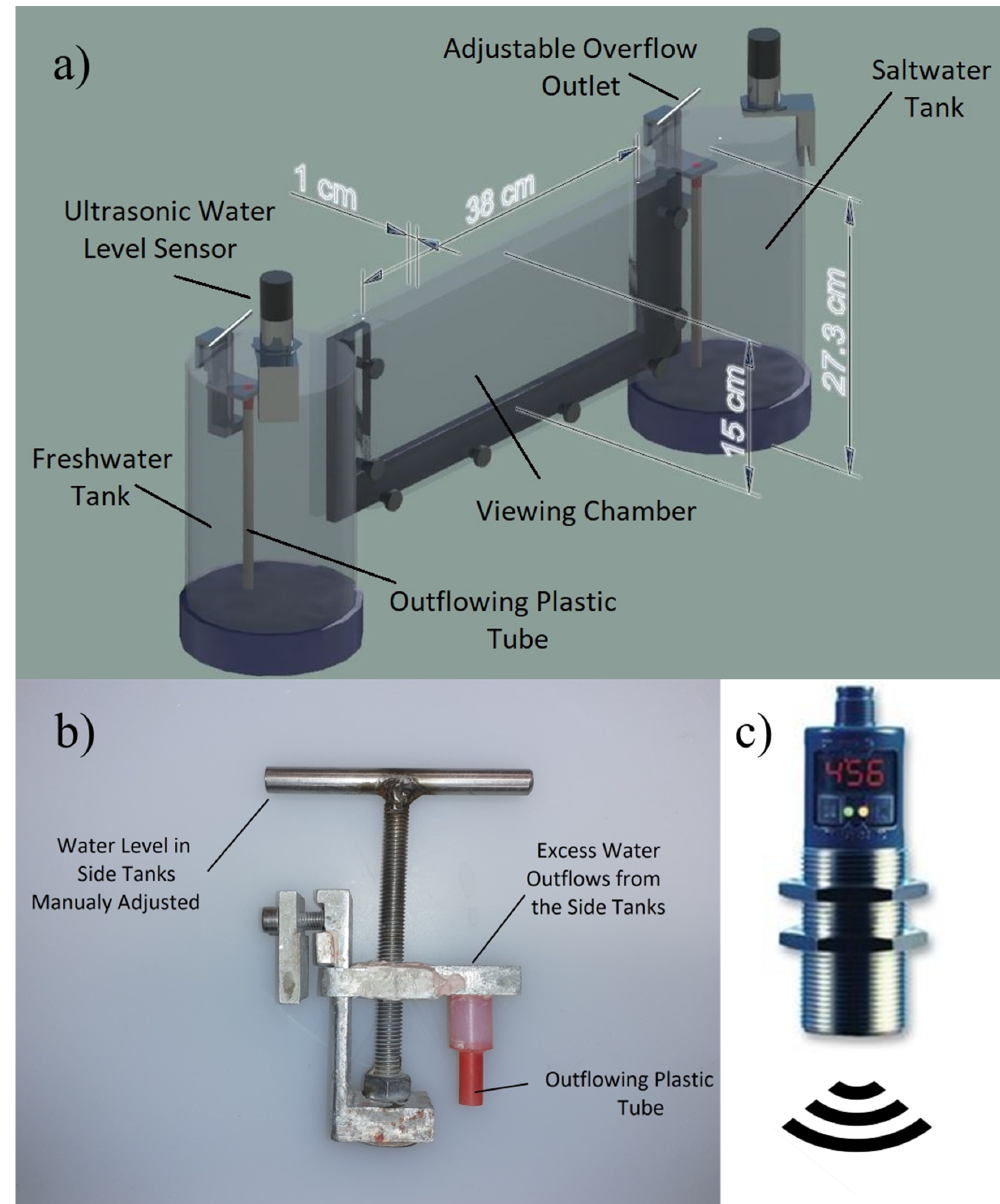
Figure 1. ( a ) Three-dimensional representation of the sandbox setup and photos of its ( b ) adjustable overflow outlet and ( c ) ultrasonic sensor components [48] .